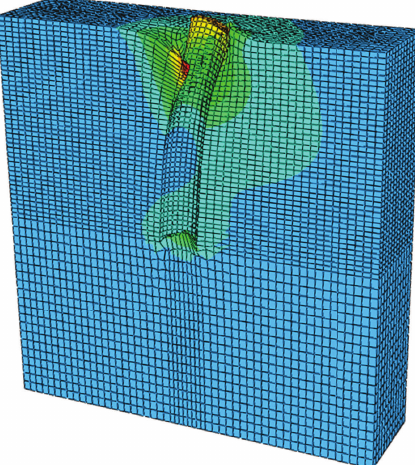
F 5: Deformed mesh of the pile foundation in 3D nonlinear